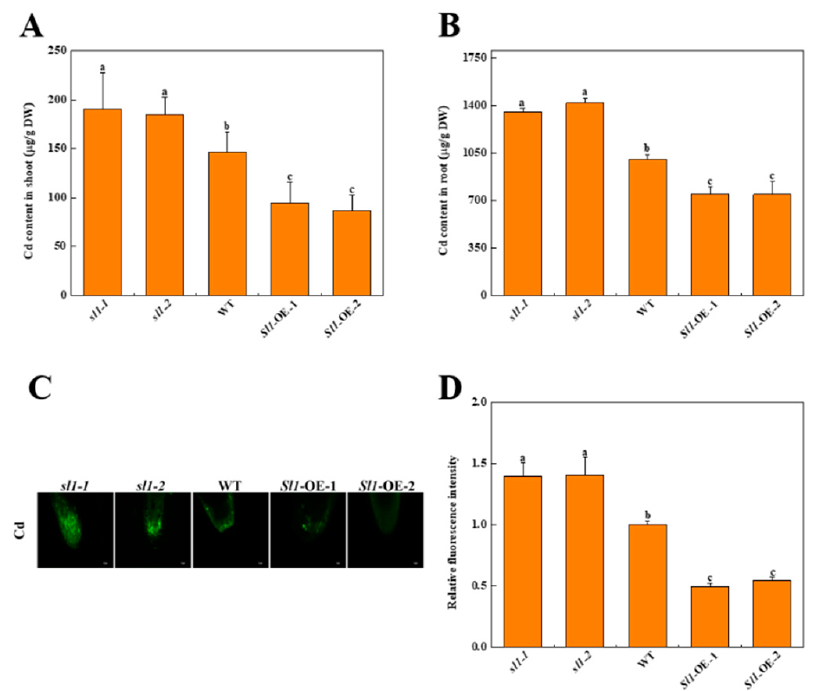
Figure 5. Sl1 decreases Cd content in tomato plants under Cd stress. The Cd content in the shoot ( A ) and root ( B ) of Sl1 mutant lines ( sl1-1/2 ), wild-type (WT), and Sl1 overexpressing lines ( Sl1 -OE-1/2) under Cd stress for 10 d. ( C ) Cd accumulation in tomato root tips stained by the Cd-specific probe Leadmium TM Green AM. Bar = 25 µ m. ( D ) Relative fluorescence intensity of Cd staining over tomato root tips of sl1 mutants, wild-type, and Sl1 overexpressing lines after 10 d Cd treatment. The relative fluorescence intensity is normalized to the intensity of wild-type in ( C ). The data presented here are the average of three biological replicates ( ± SD). Different letters indicate a significant difference ( p < 0.05, Tukey’s test).